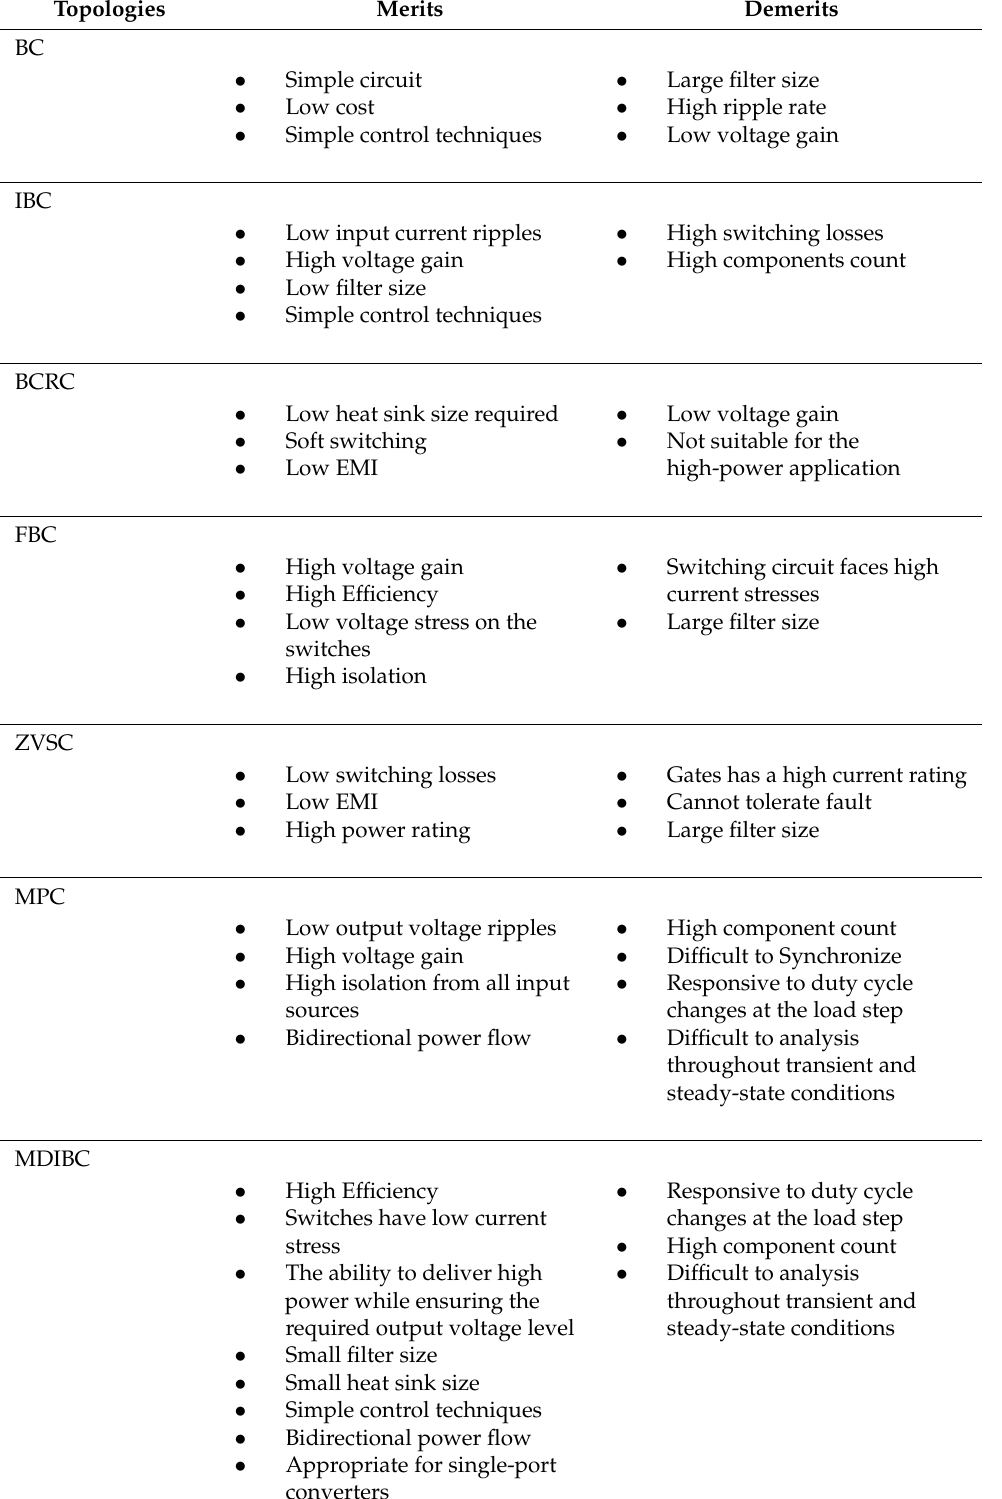
Table 11. Summary of DC–DC converters